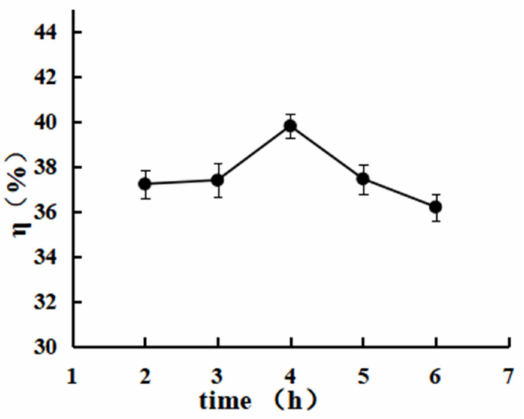
Figure 6. Effect of the reaction time on the grafting rate.